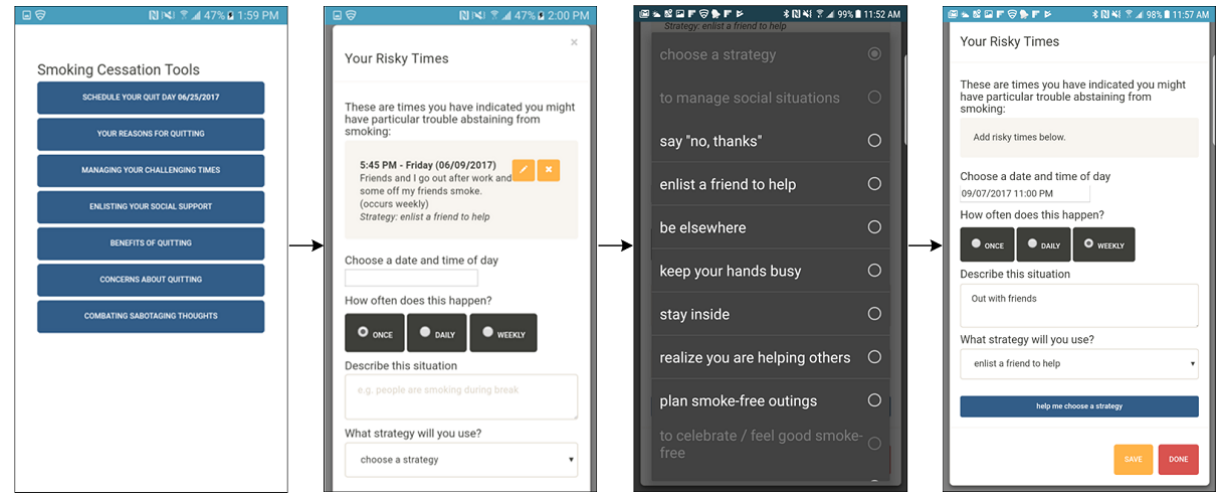
Figure 5. Screenshots of completing the ad libitum tool Risky Times in SiS1. SiS: Smiling Instead of